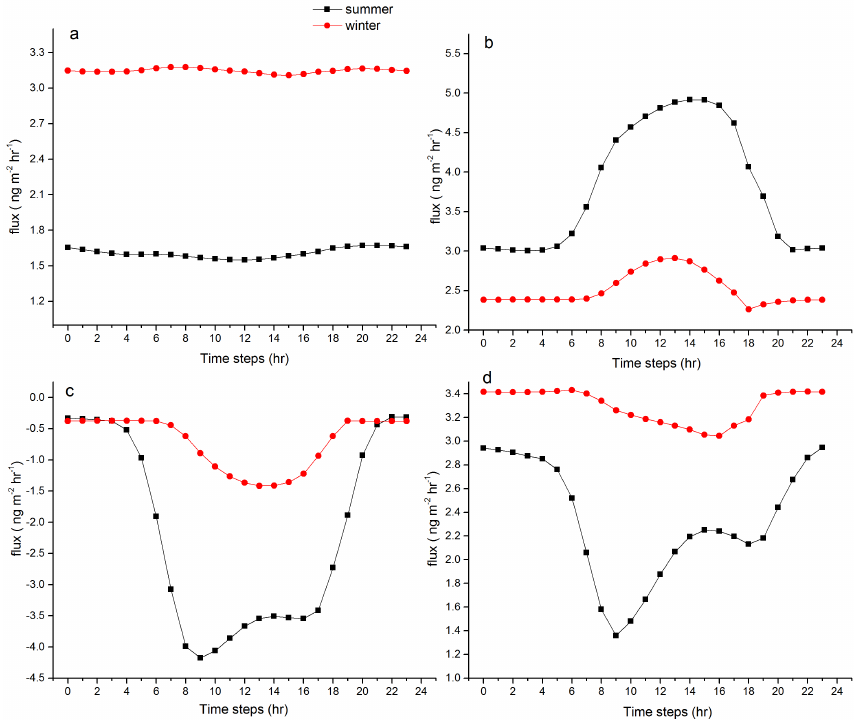
Figure 4. Diurnal variation of mean simulated Hg 0 for the entire model domain (07:00local time): (a) flux from water bodies, (b) total flux from soils (soil under the canopy and bare lands), (c) flux from foliage and (d) flux for the total domain.